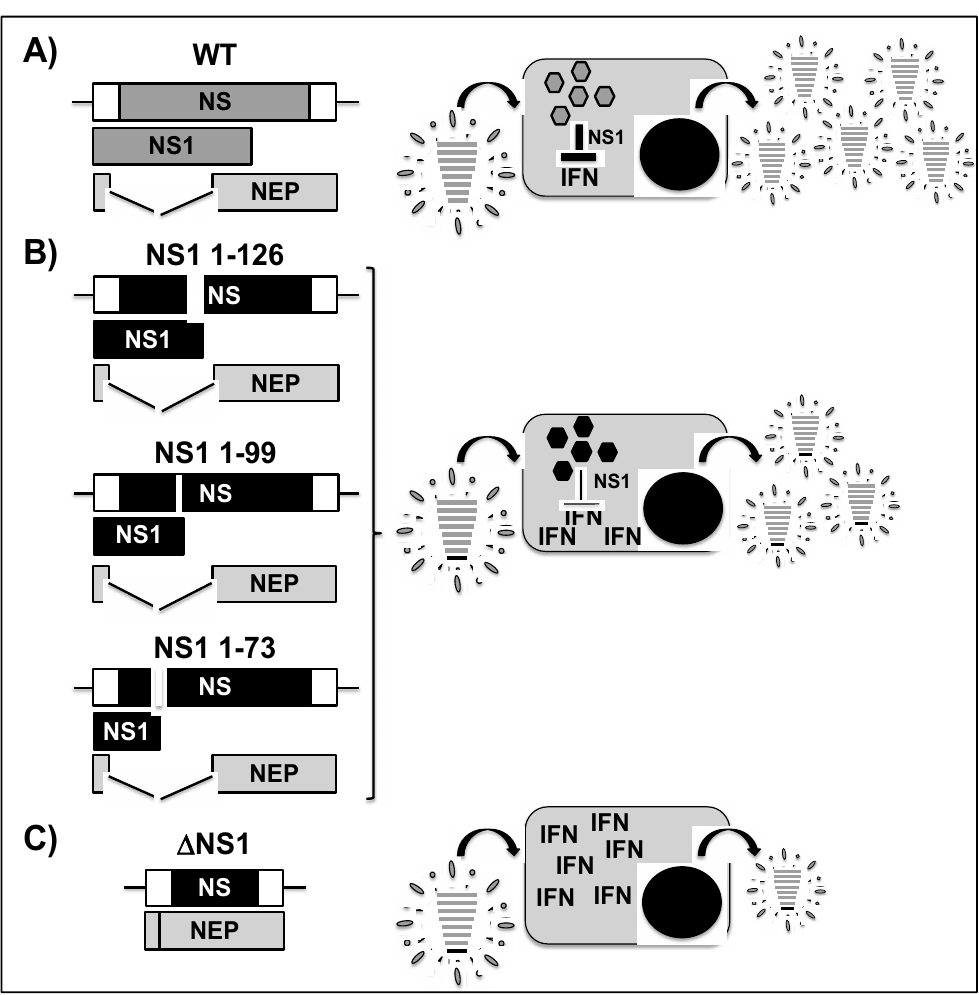
Figure 5. LAIV based on truncations and/or deletion of the viral NS1: Schematic representation of wild-type, WT ( A ), NS1 truncated ( B ), or NS1 deficient ( C ) recombinant IAV. WT NS vRNA is represented in gray boxes. WT NS1 and NEP open reading frames (ORFs) are represented as dark and light gray boxes, respectively. Modified NS segments and truncated NS1 ORFs are indicated in black boxes. White lines represent stop codons. White boxes indicate the packaging signals located at the 3´and 5´ ends of the NS vRNA. Lines at the end of the NS vRNA indicate the 3´and 5´ NCR. Expression of WT NS1 protein ( A ) results in inhibition of interferon (IFN) induction and efficient viral replication. NS1 1–126 (top), 1–99 (middle), or 1–73 (bottom) truncations in the NS1 ORF ( B ) or deletion of